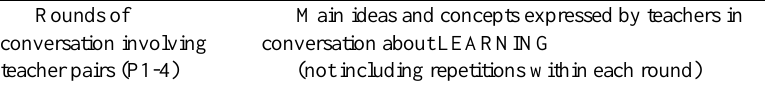
Ideas and concepts emerging in teachers’ conversations about